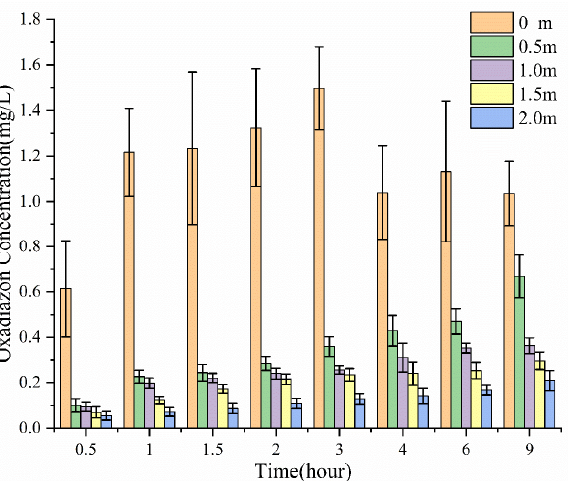
Figure 3. Concentration of oxadiazon in the water at different times and different distances from the deposition point of EC. Most of the emulsifiers used in agriculture are a combination of nonionic and whole can be adjusted by changing the ratio of nonionic and anionic emulsifiers. A number of emulsifiers were screened with different ratios, compared the emulsification effects of emulsifiers at different ratios, and obtained the best ratio of S409. The type and concentration of surfactant in SO will affect its emulsification performance. We found that SO containing 10 wt % S409 has the best emulsification effect, followed by that containing 5 wt % S409. SO containing 5 wt % S601 hardly emulsifies, and SO without surfactants does not emulsify. From Figure 4, SO containing 10 wt % S409 can transport pesticide into water at a faster rate, and the pesticide concentration reaches 0.89 mg/L 6 h later at 0.5 m from the deposition point. When using only 5 wt % S409, the pesticide is also transported into water, but the transmission rate is significantly slower, and the concentration at 0.5 m away after 6 h is only 0.42 mg/L. When using the SO with 5 wt % S601, the pesticide transport into water is even slower (concentration: 0.14 mg/L), although the performance is still better than SO without surfactant (concentration: 0.04 mg/L). This shows that under the same conditions, an SO with better emulsifying performance can carry more pesticide into water at a faster rate, because of the enhanced formation of oil ‐ in ‐ water emulsion at the interface.